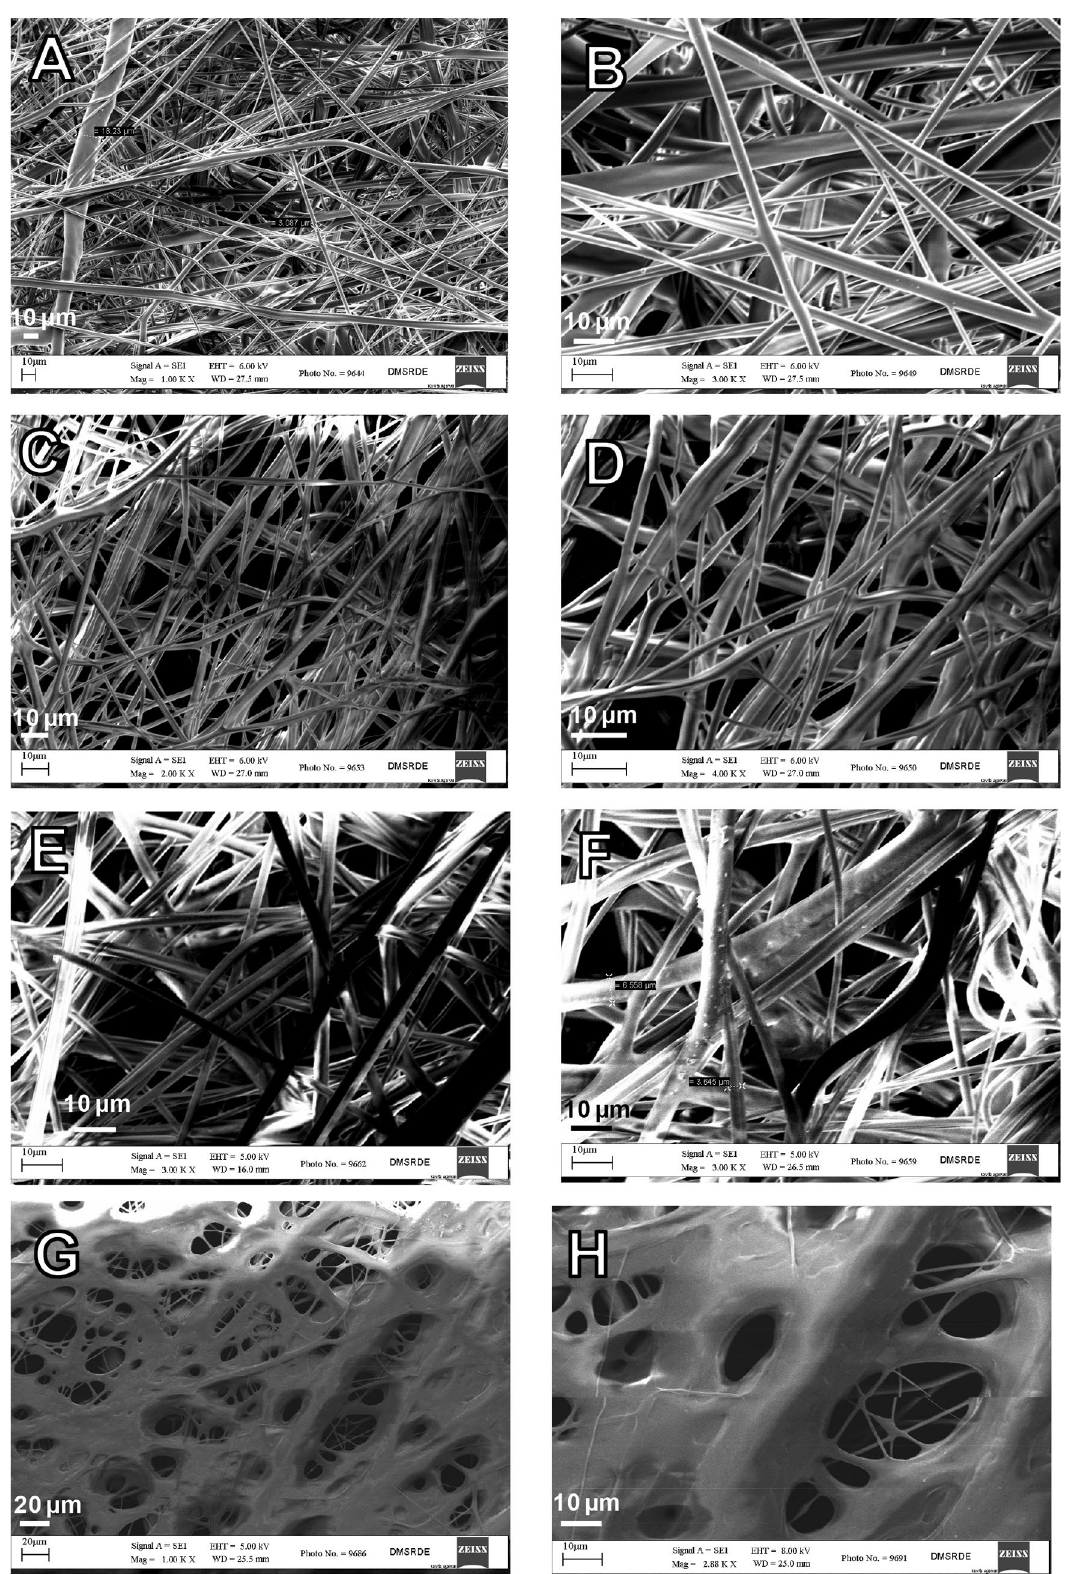
Figure 7. SEM images of the microscopic structure of various PP-MB-NW of sample A–H based on PFE ( A , B ) PFE: 90–99, ( C , D ) 70–90, ( E , F ) 50–60 and ( G , H )